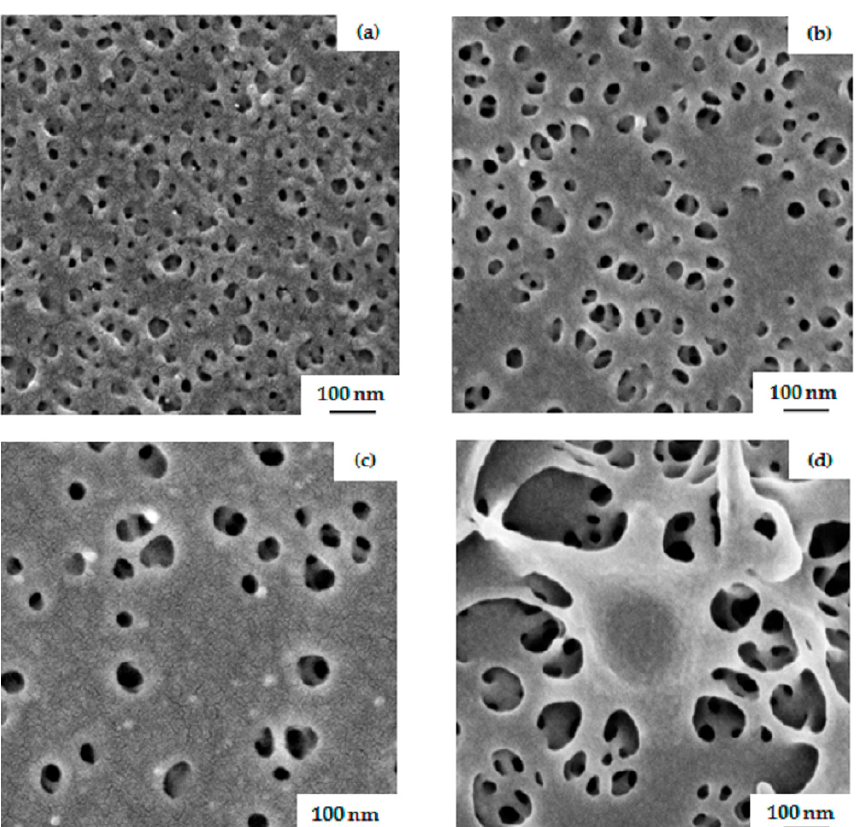
Figure 7. SEM images of surfaces of the membranes made from 24 wt% PS 81 -PSMA 19170 in THF/DMF 50/50 wt %. Evaporation time before immersion: ( a ) 5 s, ( b ) 10 s, ( c ) 20 s, ( d ) 25 s.